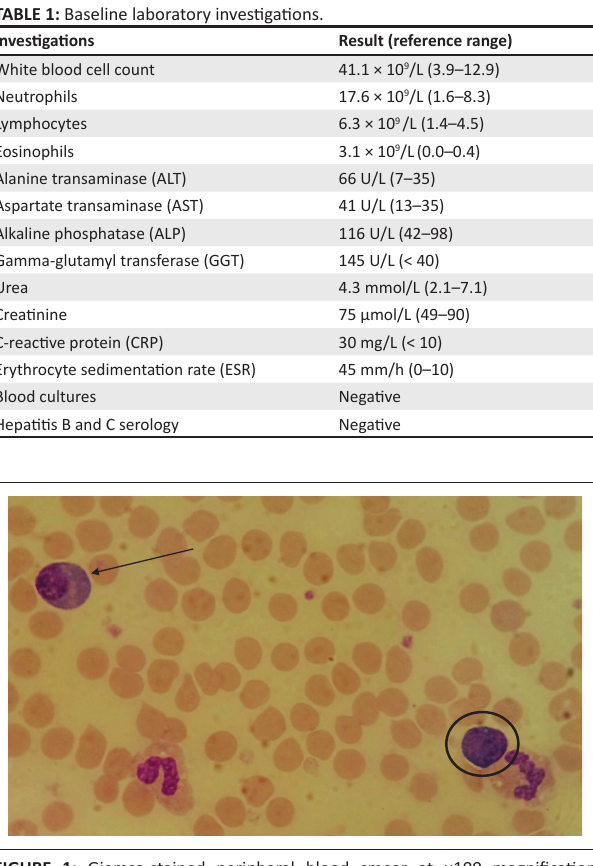
FIGURE 1: Giemsa-stained peripheral blood smear at ×100 magnification showing plasmacytoid (arrow) and atypical lymphocytes (circle). Lymphocytes ranged from small to intermediate in size with deeply basophilic cytoplasm, eccentric nuclei and nuclear folding.